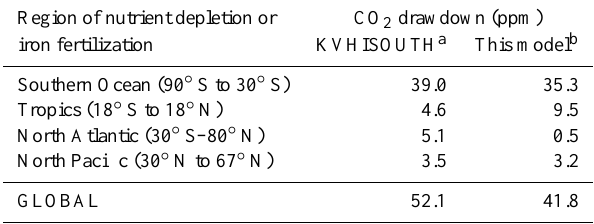
Table 1. Results of regional iron fertilization simulations in which the effect of iron fertilization is assumed to be continuous for a pe- riod of 100 years. The total amount of carbon in the atmosphere- ocean system is preserved. In other words, as CO 2 is removed from the atmosphere, the CO 2 drops below its control value of 278ppm, which permits CO 2 to escape from the ocean in regions that are not being fertilized. These simulations provide an upper limit for how much CO 2 could be removed by massive regional iron fertilization. Model drift is corrected for by subtracting a control simulation in which the total amount of carbon in the system is also